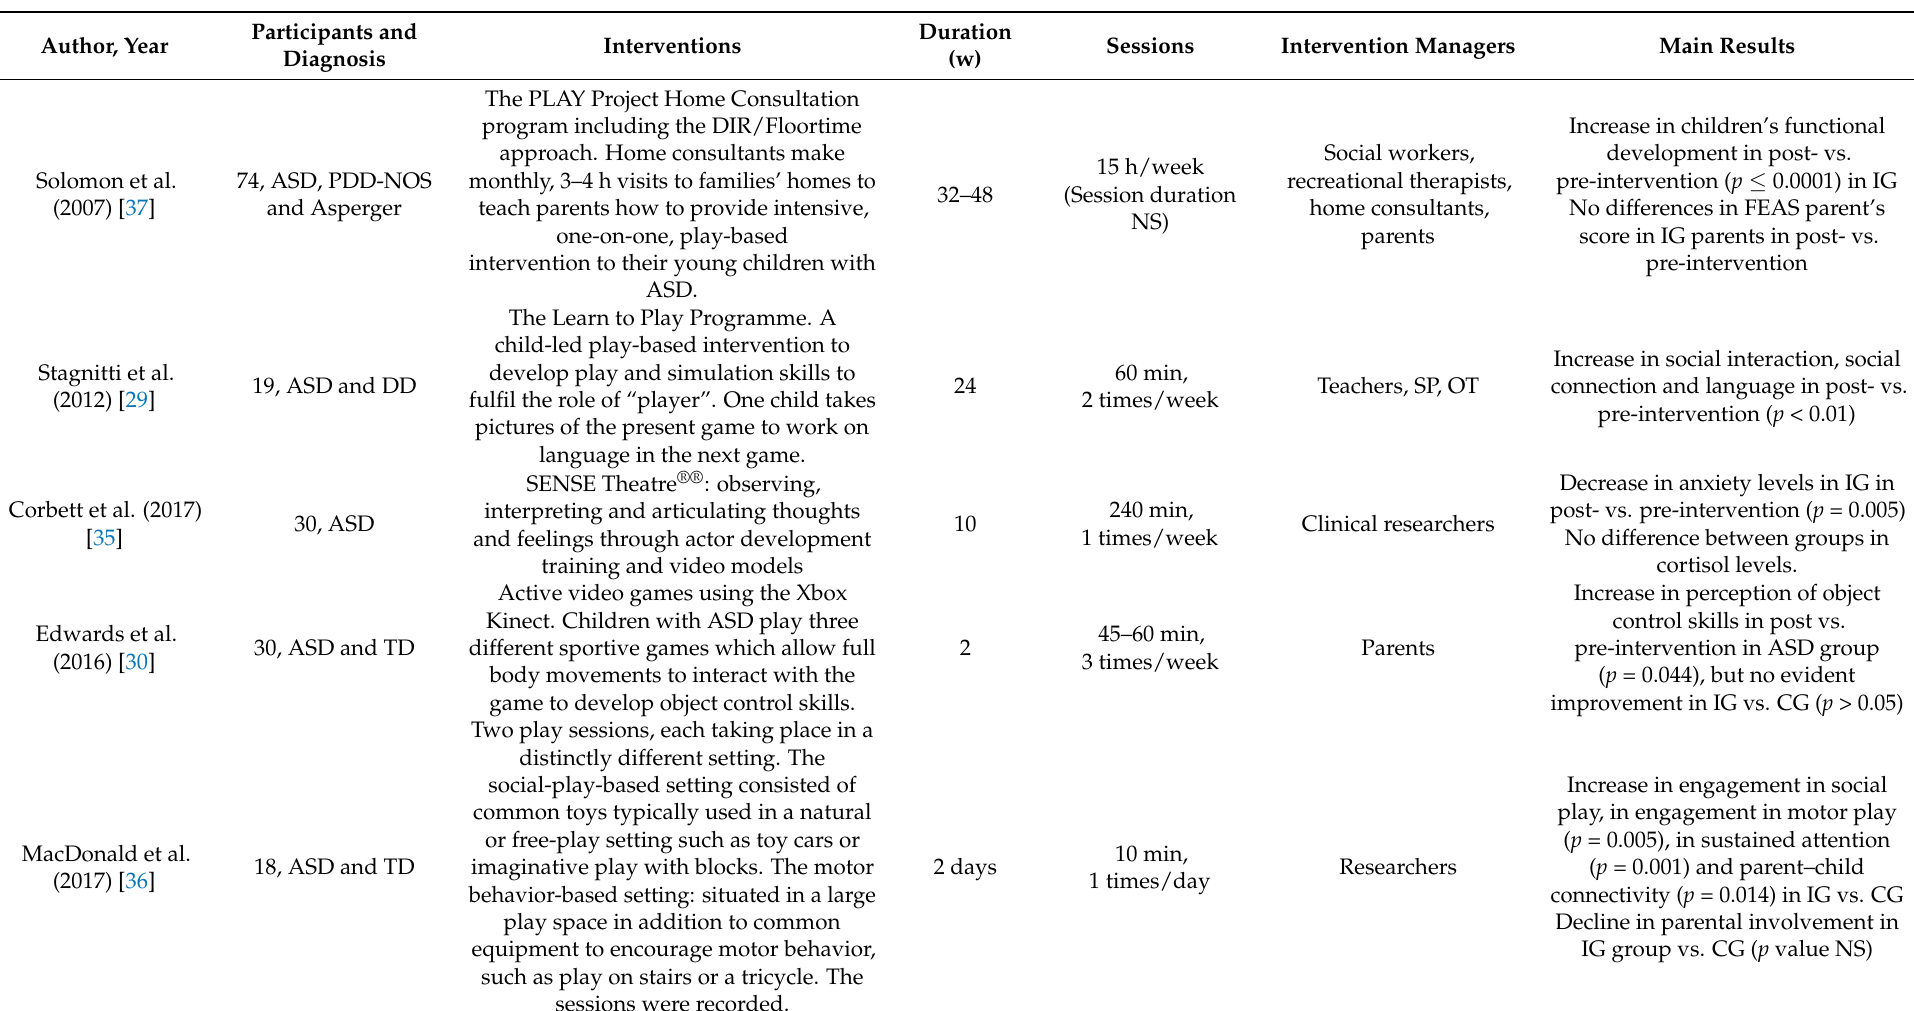
Table 3. Characteristics of the interventions performed in the included